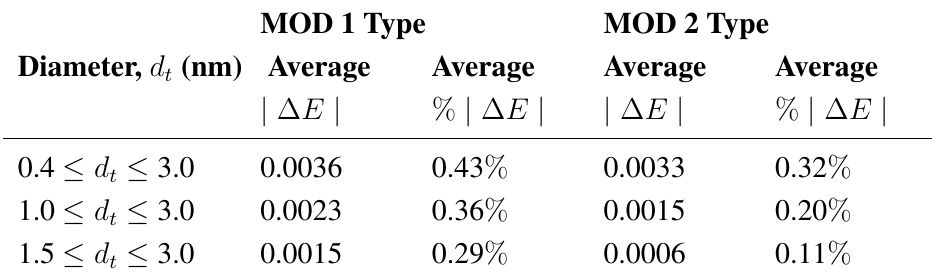
and corresponding average 11